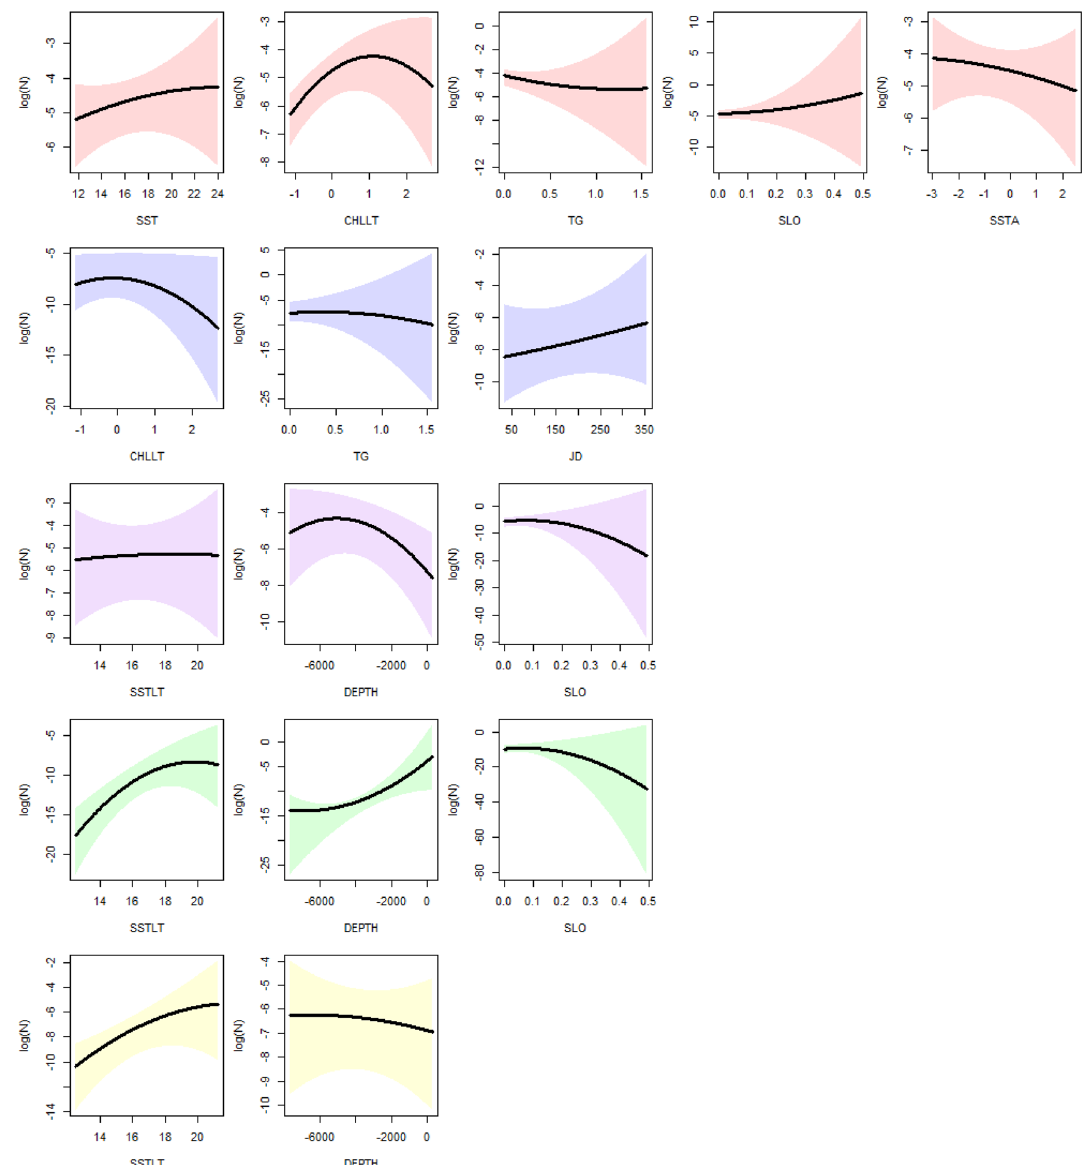
Figure 2. From top to bottom, rows show the predicted response (number of groups in log scale) to environmental predictors for ( a ) fin whale (red), ( b ) blue whale (blue), ( c ) sperm whale (purple), ( d ) dusky dolphin (green), and ( e ) common dolphins (yellow). Black thick lines indicate median responses and colored shaded areas the credible intervals. Predictors used are, sea surface temperature (SST), long-term average in sea surface temperature (SSTLT), sea surface temperature anomaly (SSTA), long term average in Chlorophyll- a concentration in log-scale (CHLLT), thermal gradients (TG), depth (DEPTH), slope (SLO) and Julian day